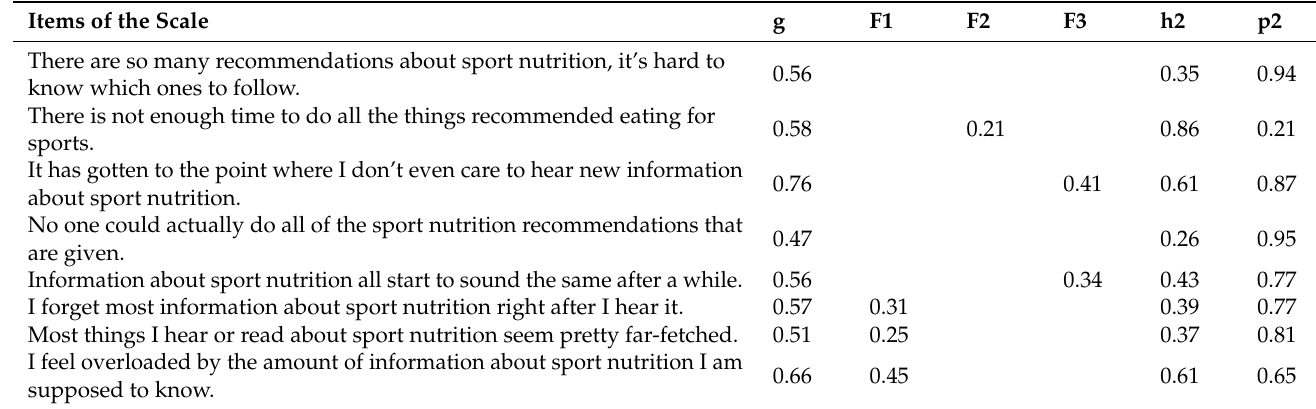
Table 12. Results of exploratory factor loading analysis by Schmid–Leiman method.